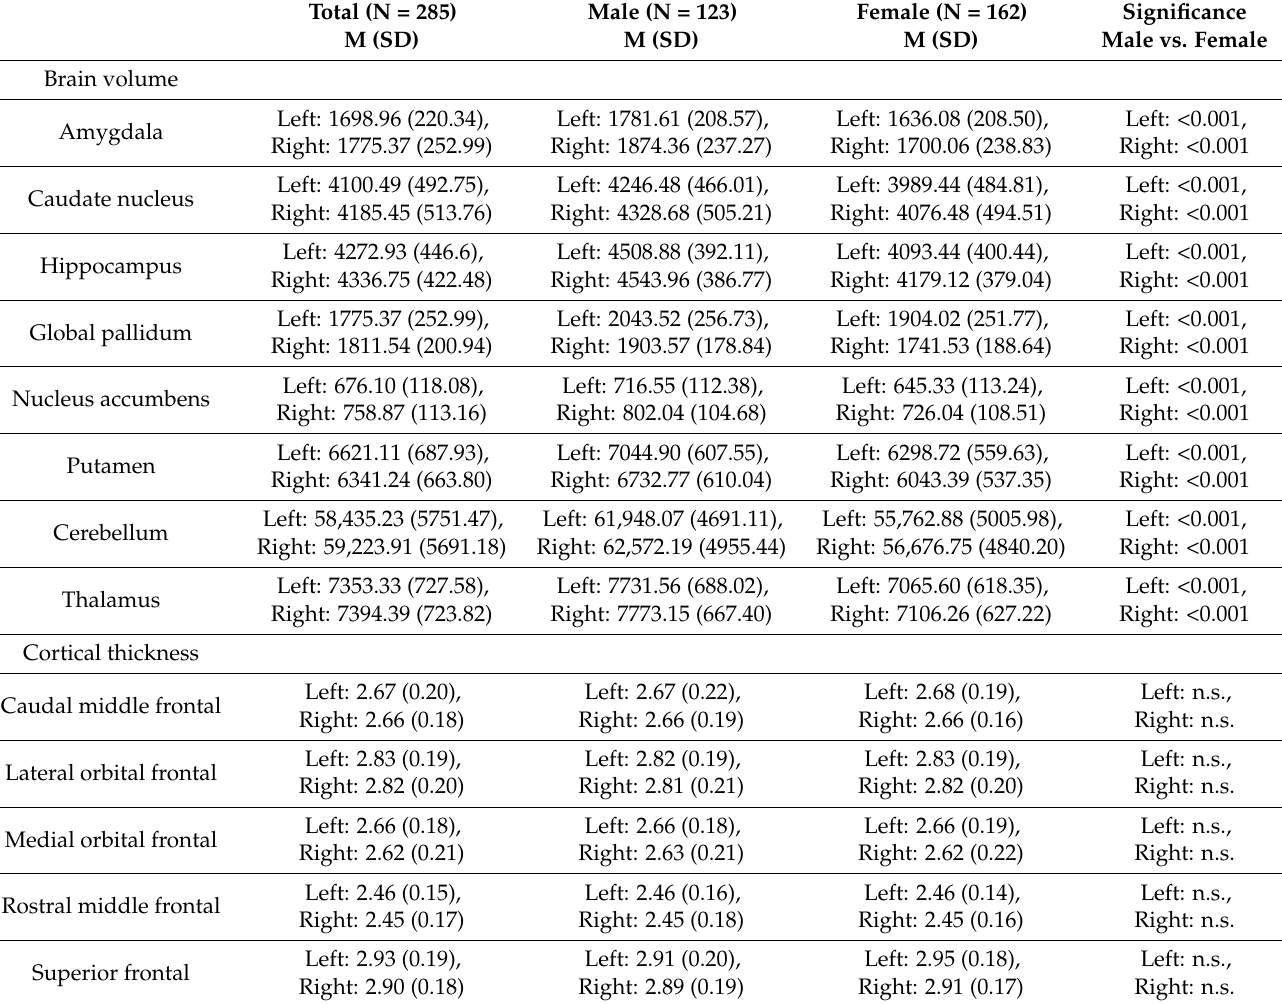
Table 2. Overview on the structural